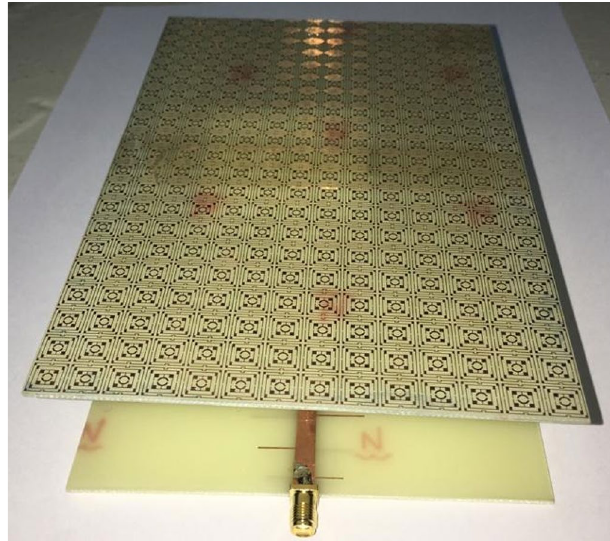
Figure 35. Fabricated antenna and metamateria